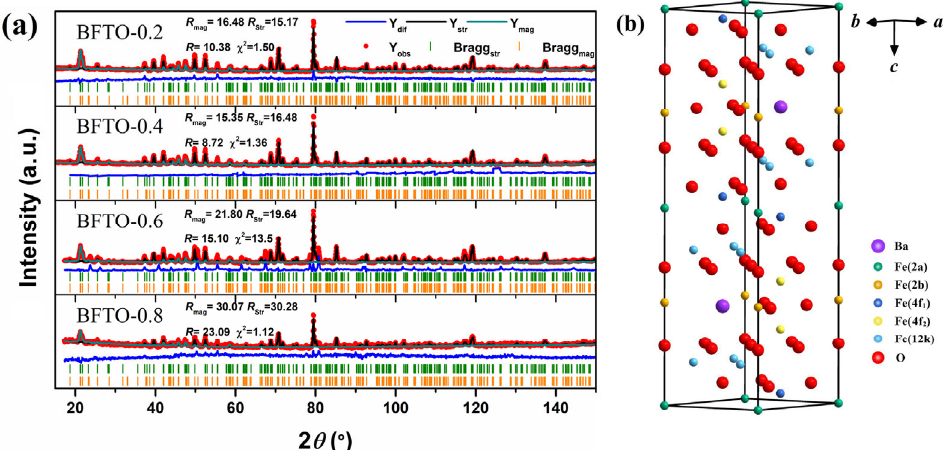
Fig. 1 (a) Neutron diffraction and corresponding refinement patterns of BFTO- x ( x = 0.2, 0.4, 0.6, 0.8) ceramics and (b) schematic structure of BaFe 12 O 19